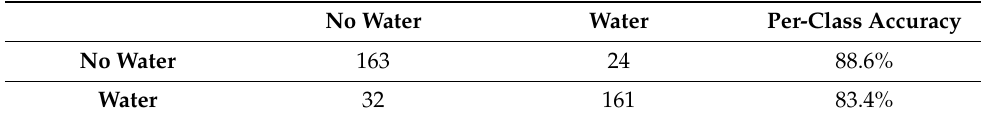
Table 7. Confusion matrix for the AlexNet model onboard Nvidia Jetson TX2.